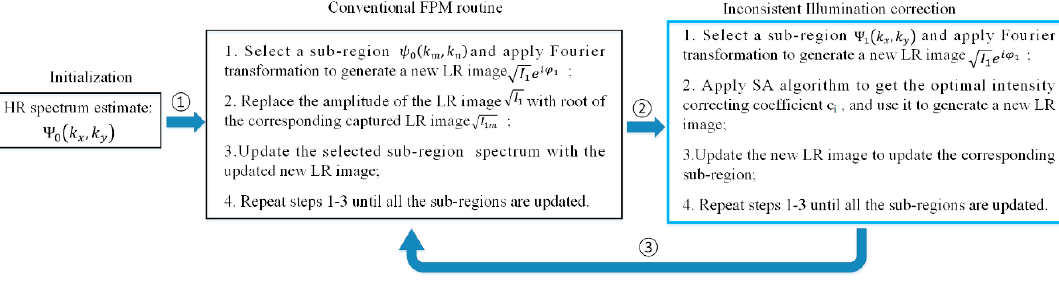
Figure 4. A flow chart of the simulated annealing (SA)-embedded FPM algorithm.